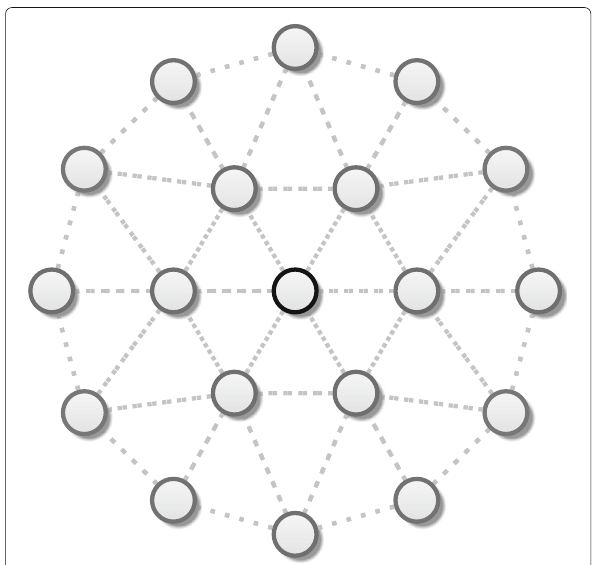
Fig. 9 A concentric network with 19 nodes